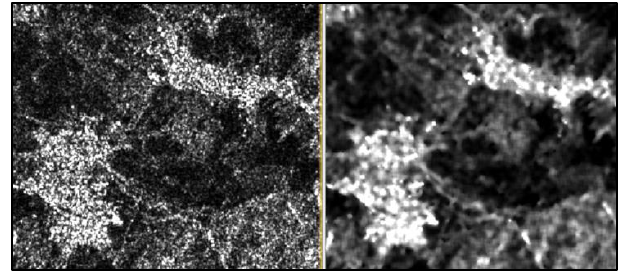
Figure 4. Speckle Filtering. View of the two villages before filtration ( left ), View after filtration ( right ). The same threshold was chosen for both images so that the water could be separated from the other objects in the environment. The filtered backscatter coefficient histogram is used, where low values correspond to water and high values to other non-water objects. By using the color manipulation methods, the water is visualized in black, and the rest of the objects in the white-gray color range.